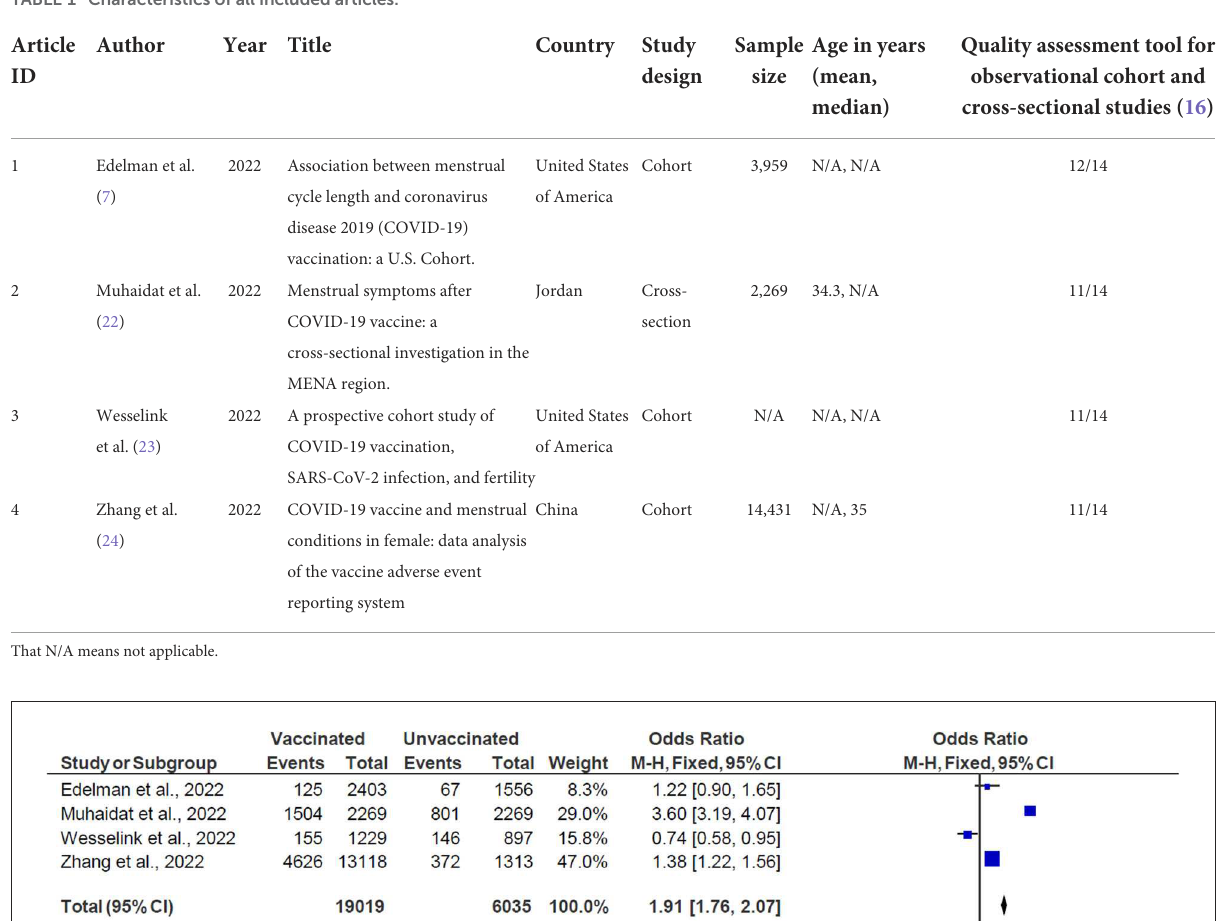
TABLE 1 Characteristics of all included articles.